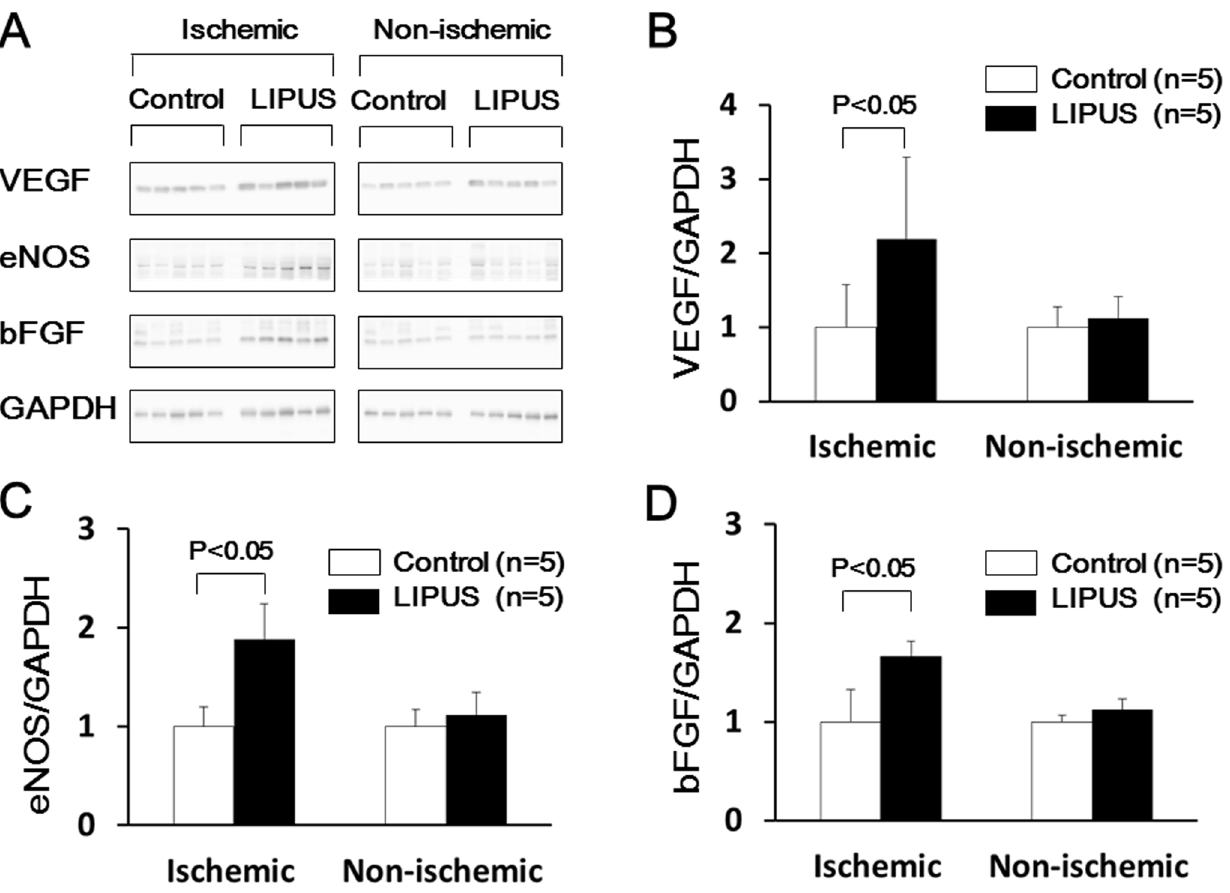
Figure 7. LIPUS treatment up-regulated protein expression of VEGF, eNOS, and bFGF in the ischemic myocardium (n=5 each). (A) Western blots of VEGF, eNOS, and bFGF. (B , D) Quantification of VEGF, eNOS, and bFGF expression.